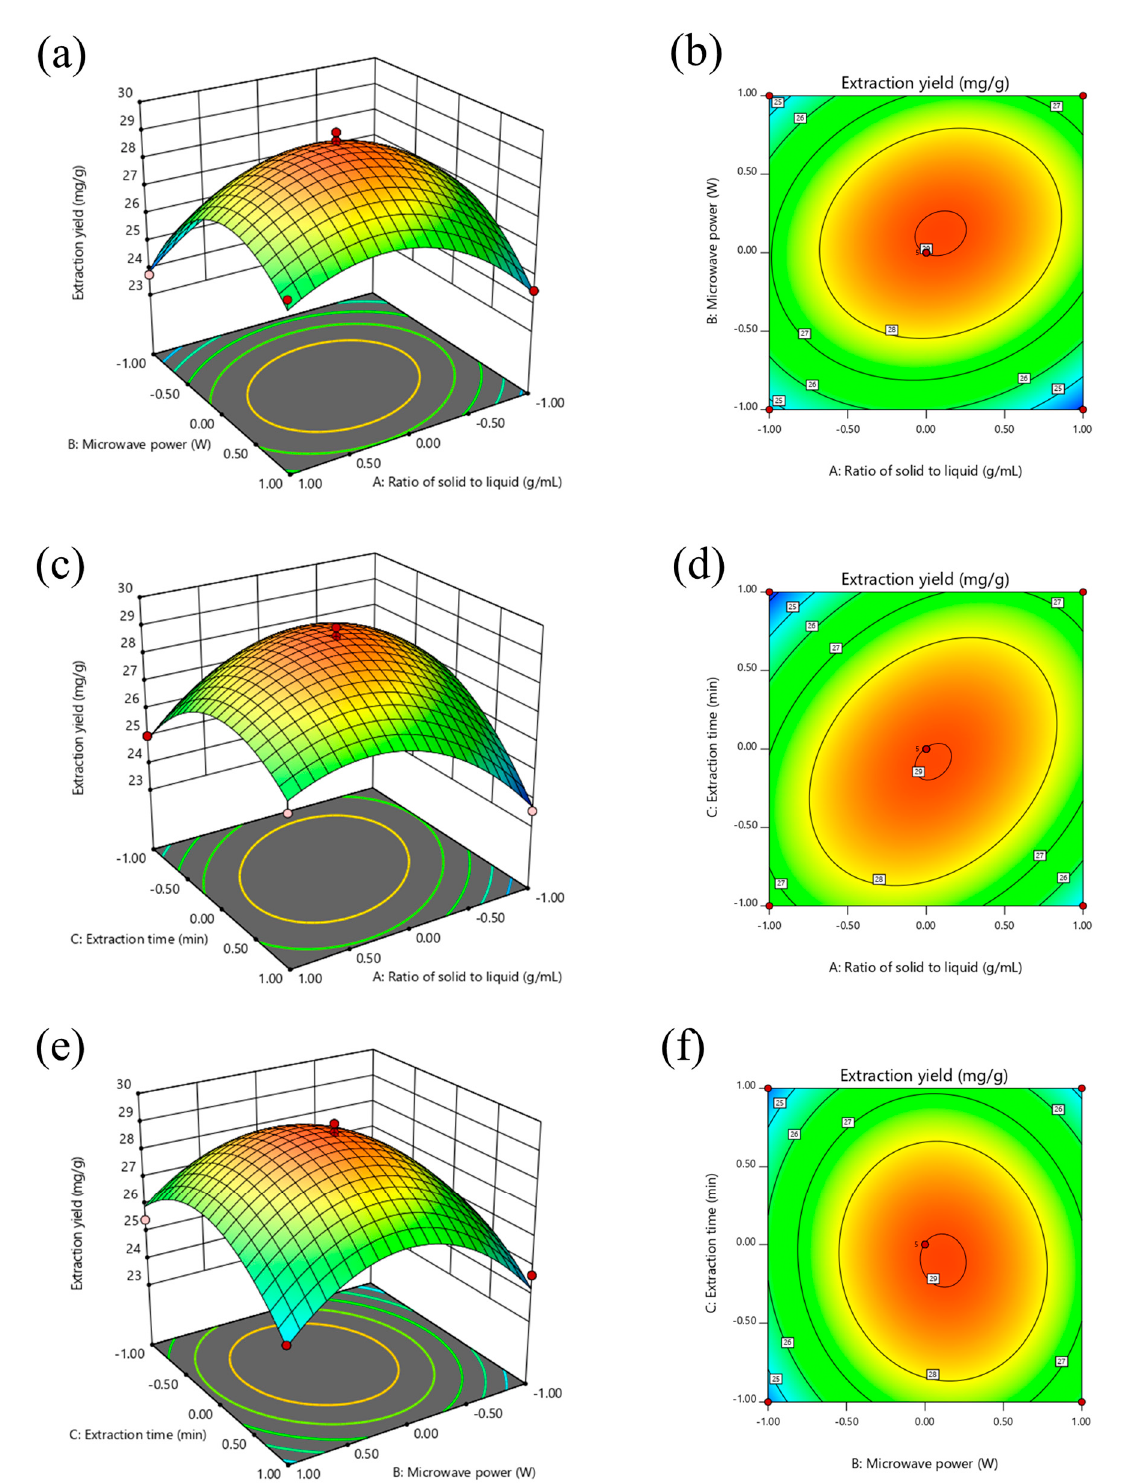
Figure 3. Three-dimensional response surface plots showing the effects of different parameters on TTC. Solid–liquid ratio and ultrasonic power ( a ); solid–liquid ratio and ethanol concentration ( b ); solid–liquid ratio and extraction time ( c ); ultrasonic power and ethanol concentration ( d ); ultrasonic power and extraction time ( e ); ethanol concentration and extraction time ( f ). Figure 3a,b show the comprehensive e ff ects of the solid–liquid ratio and microwave power on the TTC. It is clearly shown that when the solid–liquid ratio was increased to 1:20 g/mL and the microwave power increased to 400 W, the TTC increased and reached